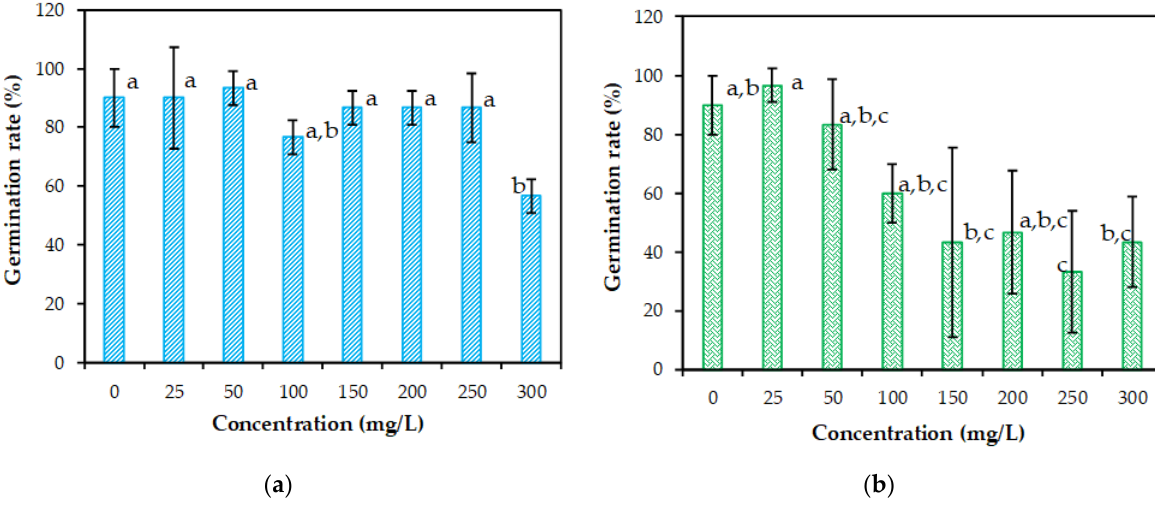
Figure 3. Seed germination rate of Brassica napus L. under ( a ) Pb(II) and ( b ) Cd(II) stress. Similar letters are statistically non-significant according to Tukey HSD test ( p < 0.05). Means that do not share a letter are significantly different from each other, followed by letters that are later in the alphabet for lower means. Error bars indicate mean ± SD